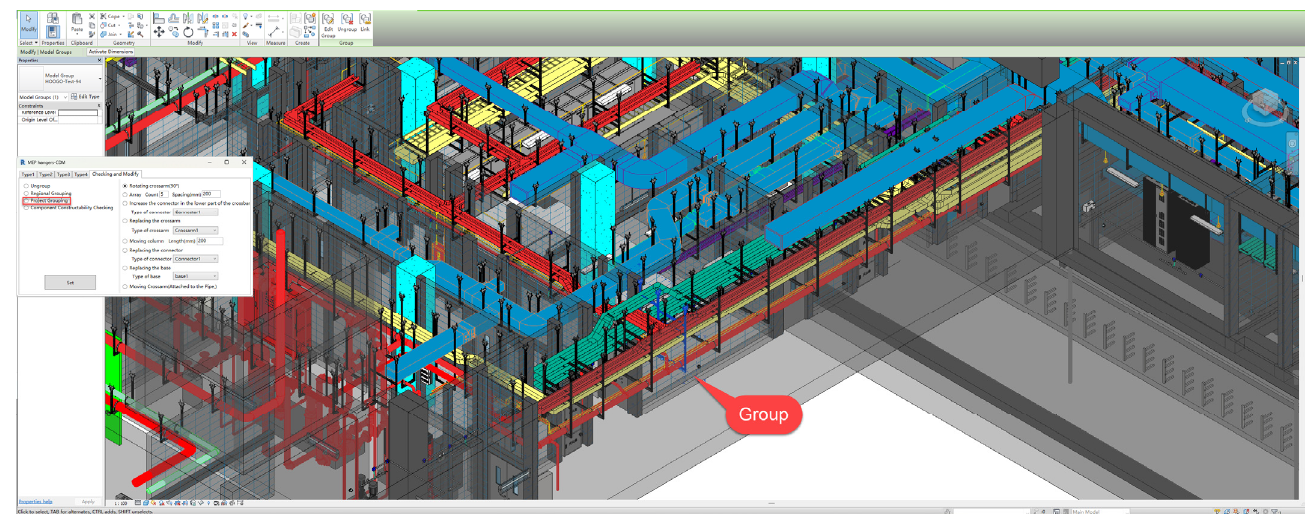
Figure 14. The result of the Automatic Grouping.